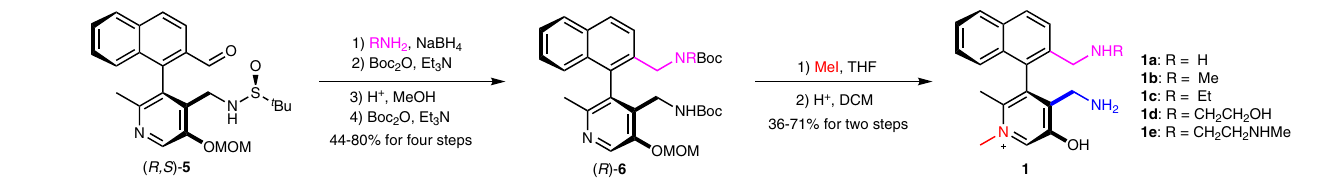
Fig. 2 Synthesis chiral pyridoxamines 1. The detailed synthetic procedures have been presented in Supplementary Information (SI). THF = tetrahydrofuran, DCM